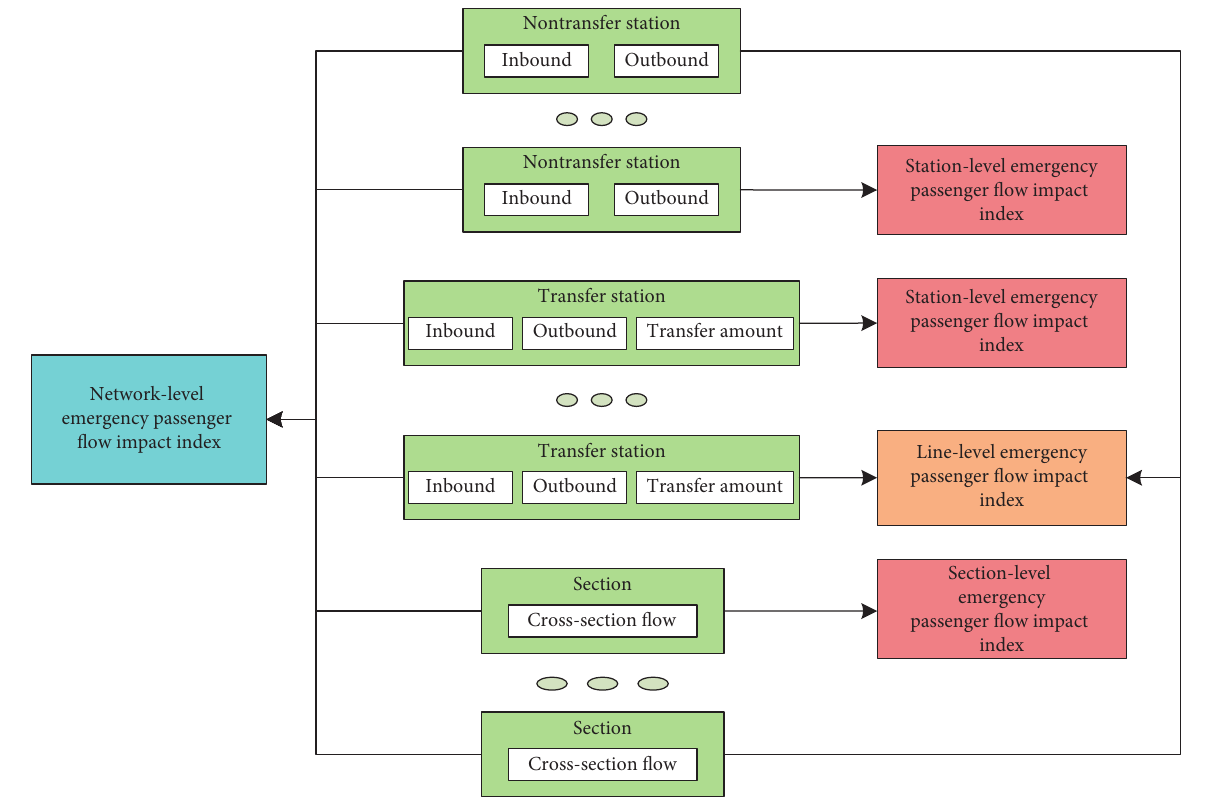
Figure 3: Passenger flow impact index system and calculation process of urban rail transit